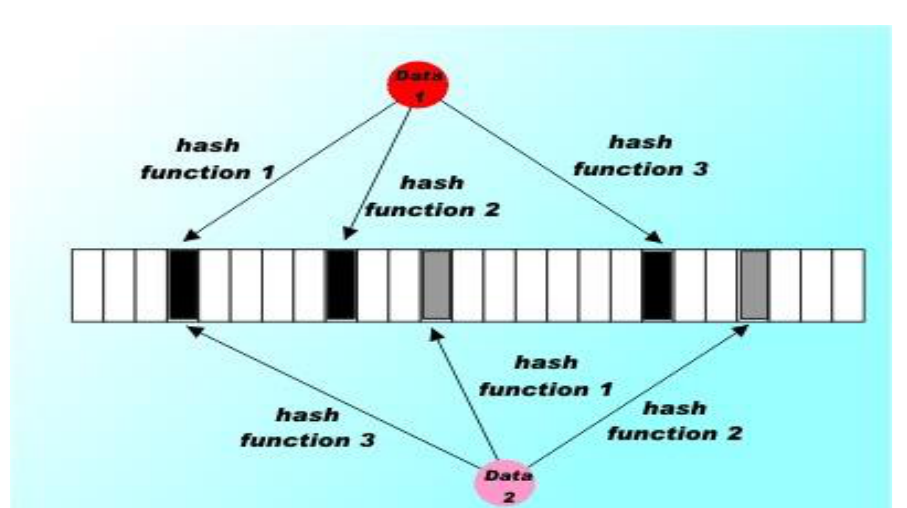
Figure 5. Bloom filter access.